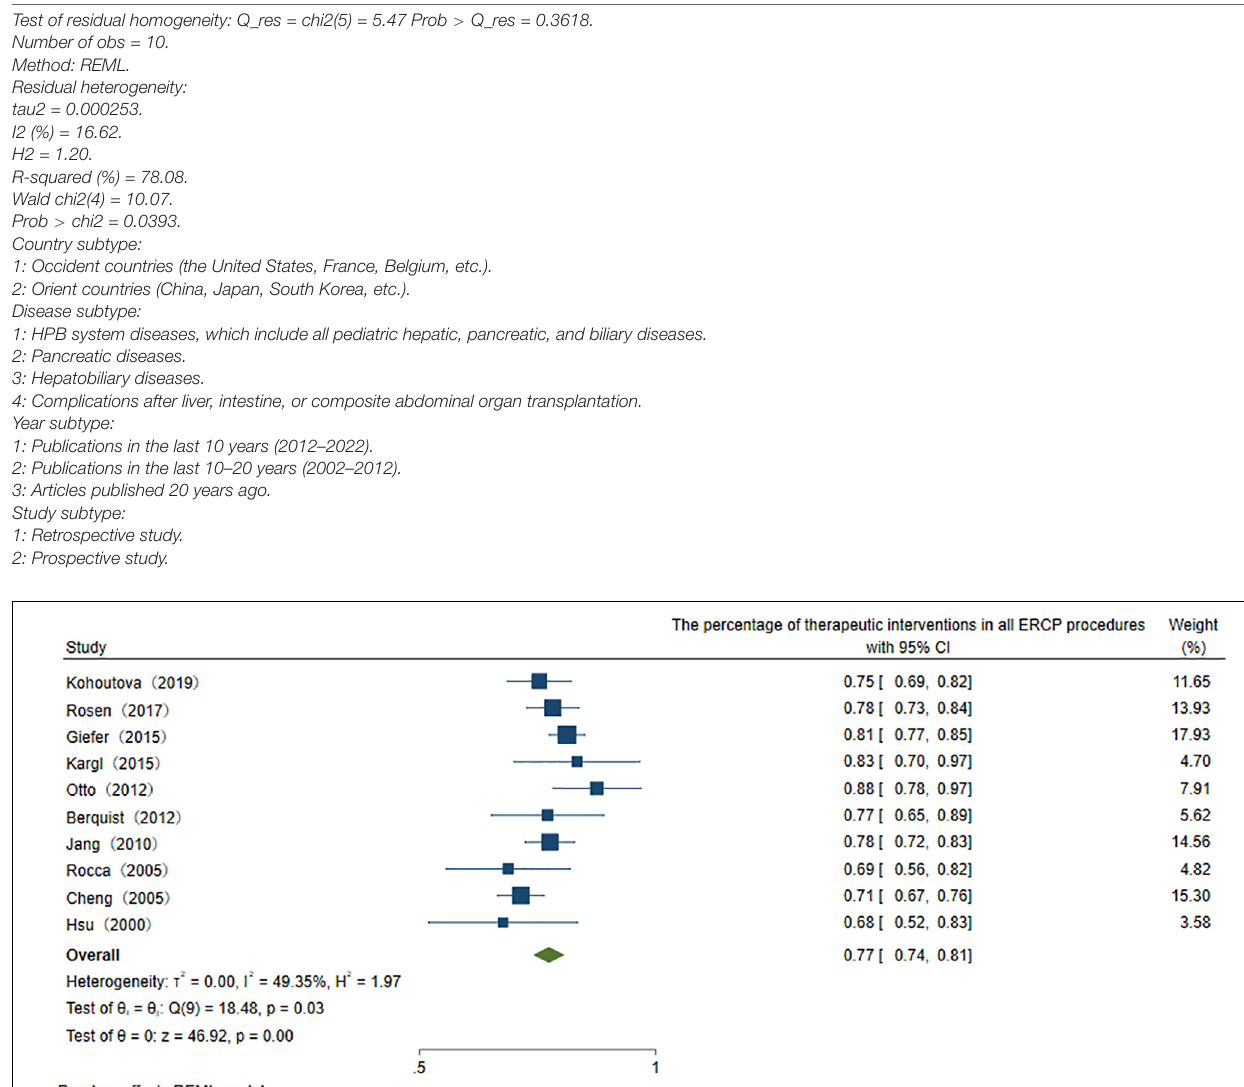
process ( Table 4 ). We analyzed several main treatment methods. ( Figure 9 ). Similarly, when pooling studies after excluding papers with high heterogeneity, the usage rate of sphincterotomy